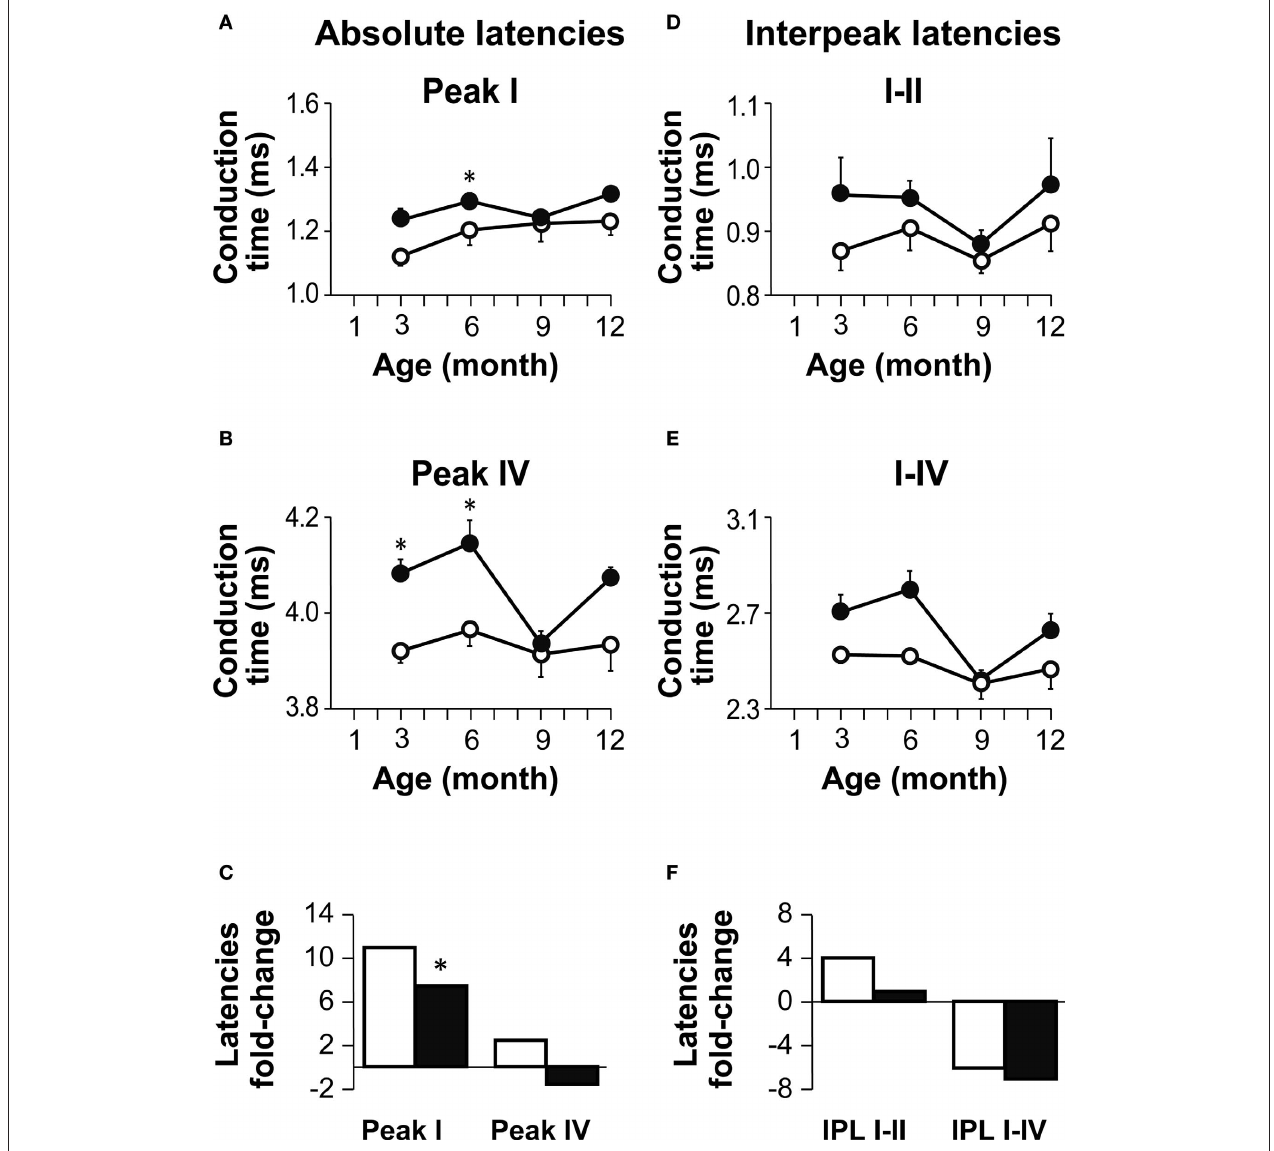
Figure 3 | Age-related changes in absolute and interpeak latencies in both genotypes. (A,B) Absolute Peak I (A) and peak IV (B) latencies obtained at 80 dB SPL. Absolute latencies are plotted for Igf1 + / + (open circles) and Igf1 − / − mice (closed circles) aged from 3 to 12 month old. (C) Percentage delay in latency with aging. Open and closed bars indicate wild type and null mice, respectively. The bars represent the percentage latency increase from 3 to 12 months of age for peaks I (bars to the left) and IV (bars to the right). The asterisk indicates that the 11% difference in peak I latency between 3- and